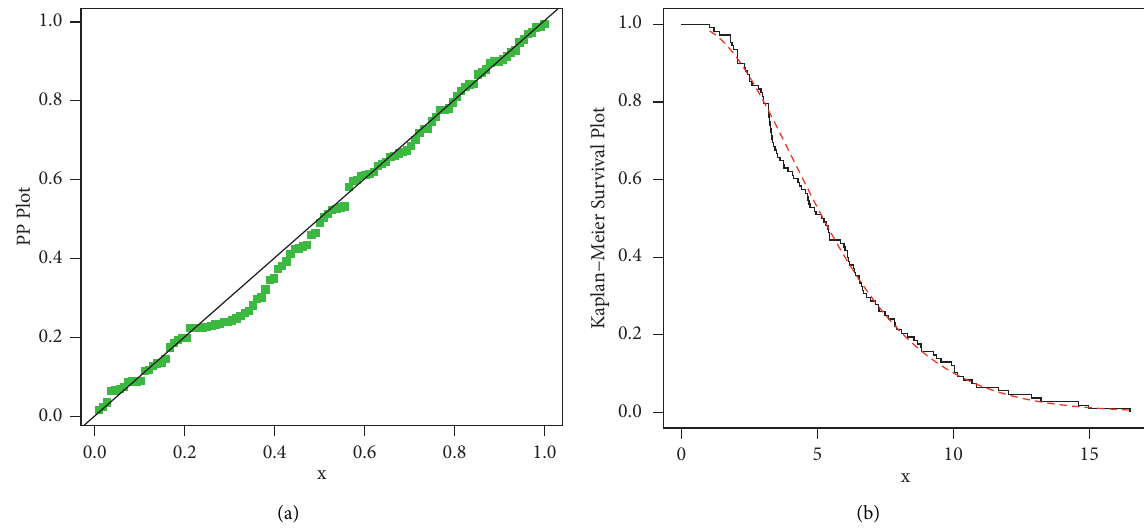
Figure 10: Best-fitted PP and Kaplan–Meier Survival plots for the proposed distribution using the third